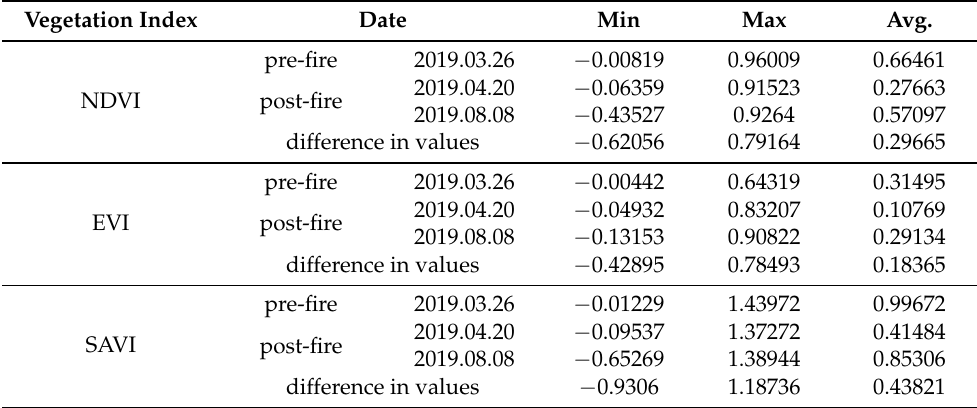
Table 3. Result of vegetation index pixel values.